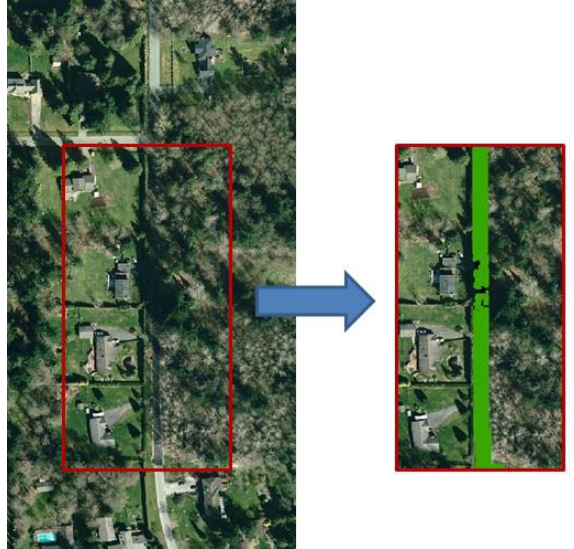
Figure5. Tree canopy obstruction resulting in misclassification within the road allowance